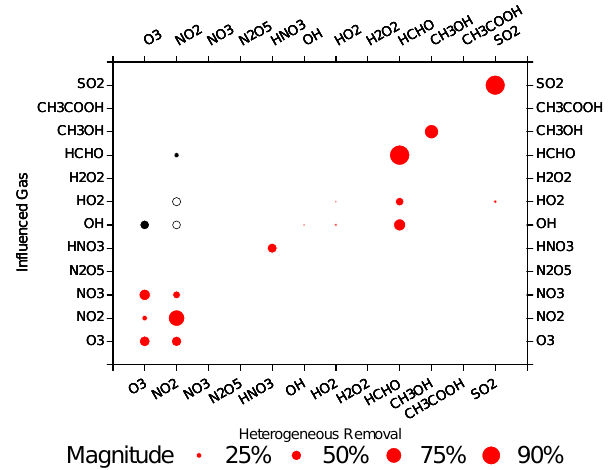
Fig. 10. Uncertainties of the tracer mixing ratios caused by each heterogeneous removal reaction. The colors red and black repre- sent negative and positive values, respectively. Hollow circle repre- sents the values scaled by 0.1. Corresponding values are shown